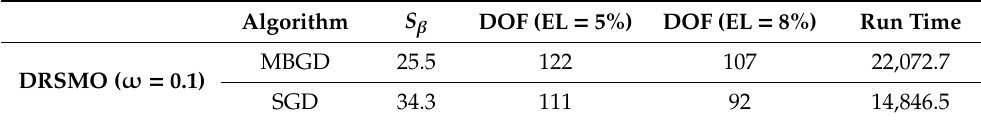
Table 4. The values of S β , DOF (nm) corresponding to ELs equal to 5% and 8% and run time (seconds) for DRSMO proceeded by the MBGD and SGD,